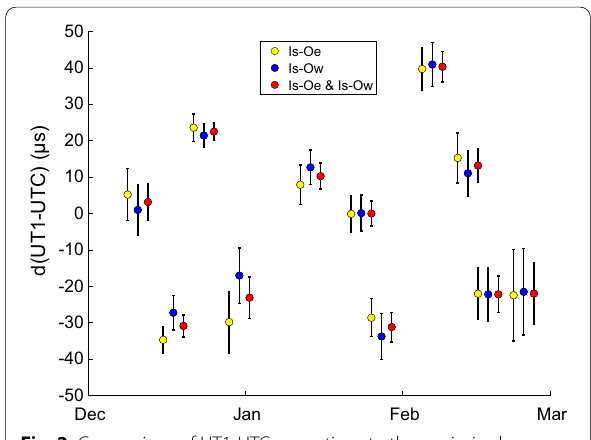
Fig. 2 Comparison of UT1-UTC corrections to the a priori values derived from analysing the VGOS-B baselines individually, i.e. Is-Oe (yellow) and Is-Ow (blue), and in a common analysis Is-Oe & Is-Ow (red). The symbols are offset along the x-axis to improve readability of the graph. The uncertainties shown are 1